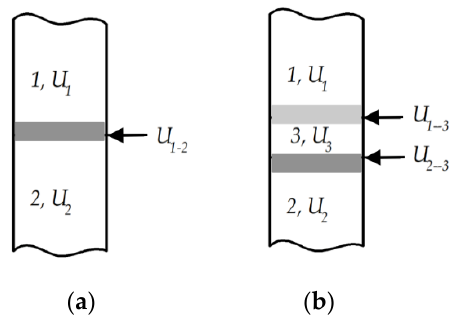
Figure 6. The simplified scheme of contact areas: ( a ) contact area directly between the metal ( 1 ) of strength U 1 and oxide ( 2 ) of strength U 2 ; ( b ) presence of the transitional phase ( 3 ) of strength U 3 between the metal ( 1 ) and oxide ( 2 ).